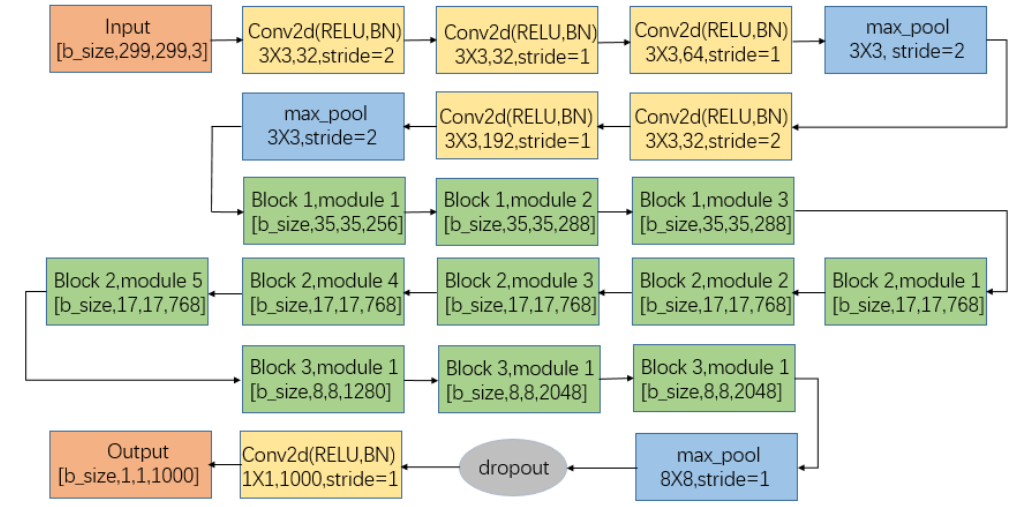
Figure 1. Convolutional neural network (CNN) network model structure diagram.